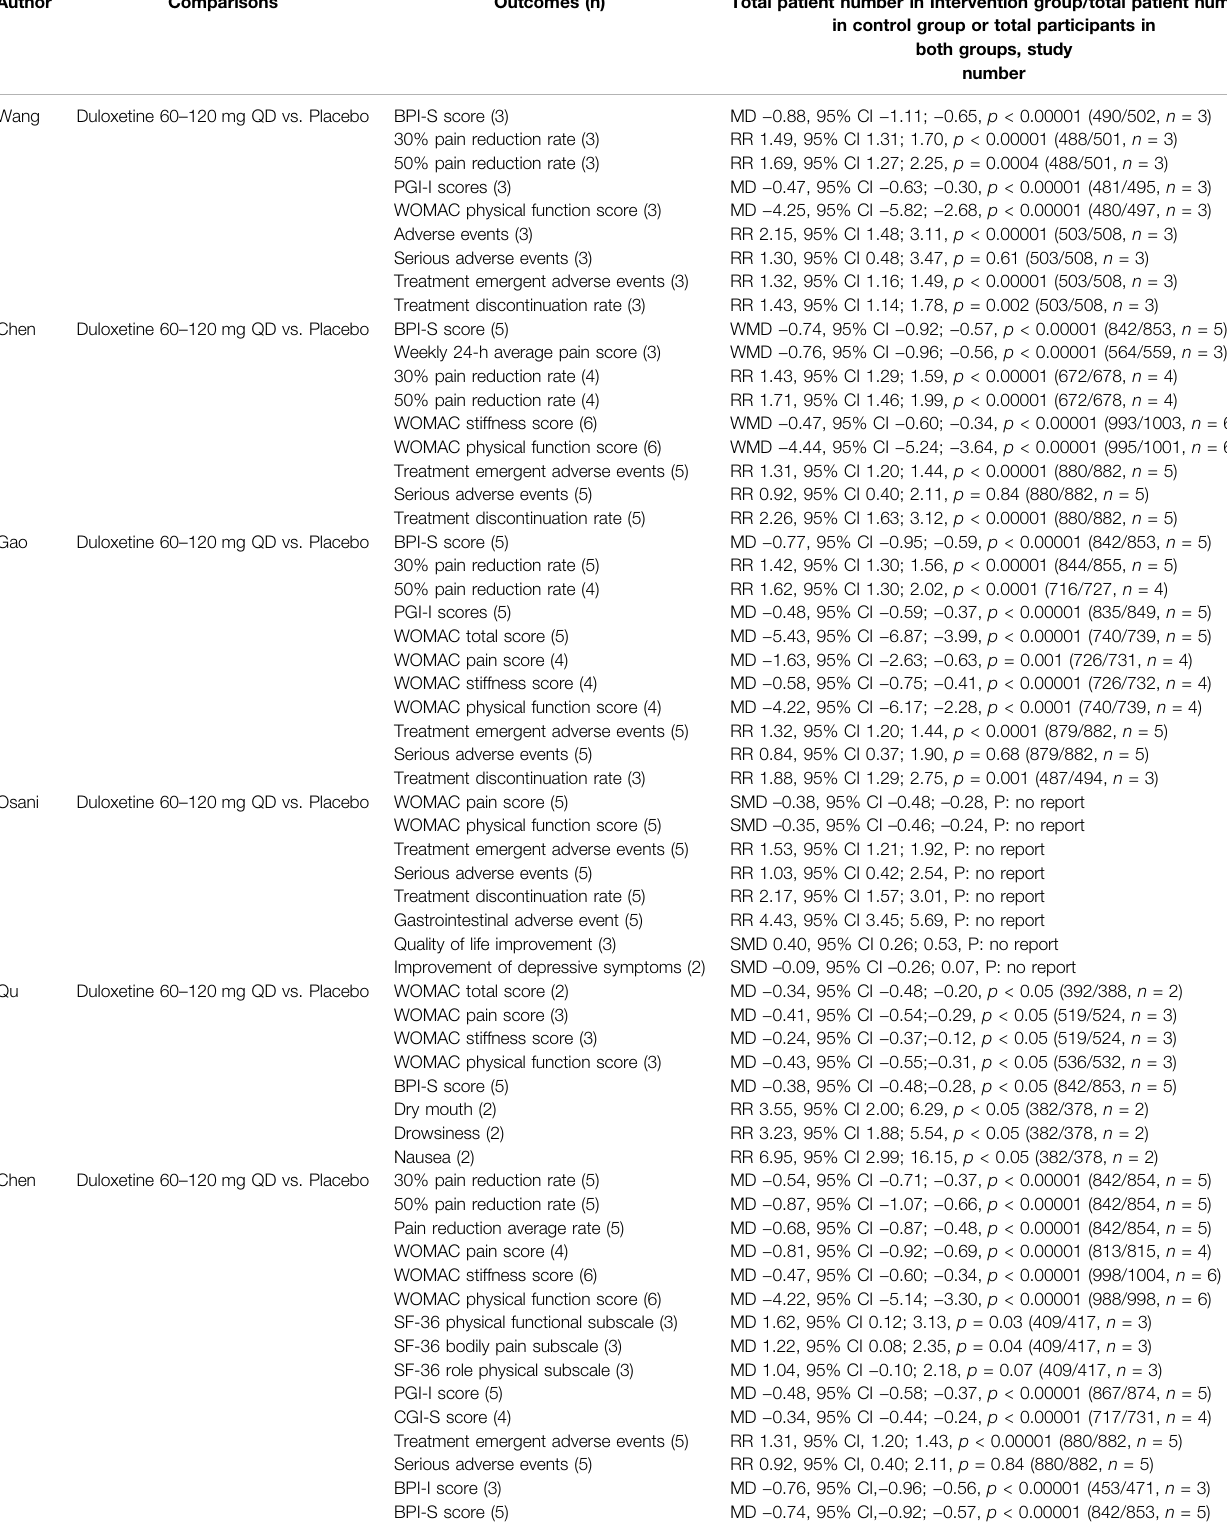
TABLE 7 | Results of included